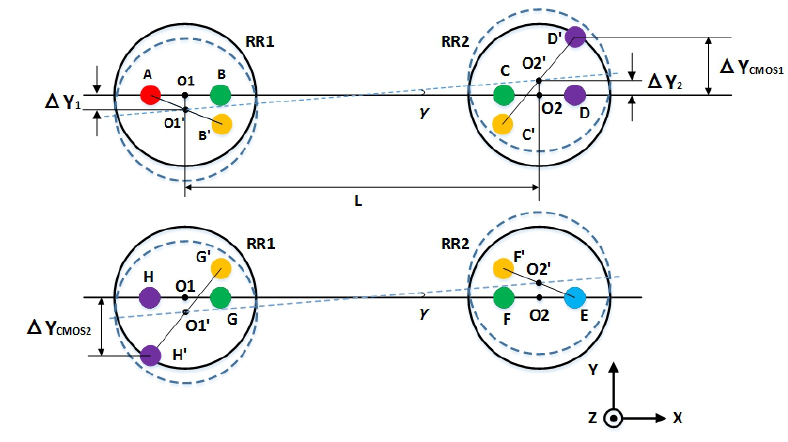
Figure 5. Measurement principle of